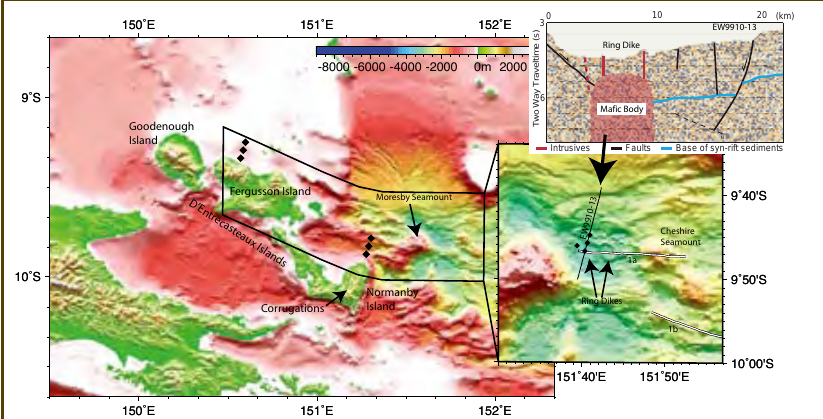
Figure 6. Western Woodlark Basin and easternmost Papuan Peninsula showing the locations of proposed drill sites (black dots). Inset (right) shows details of the rifting-spreading